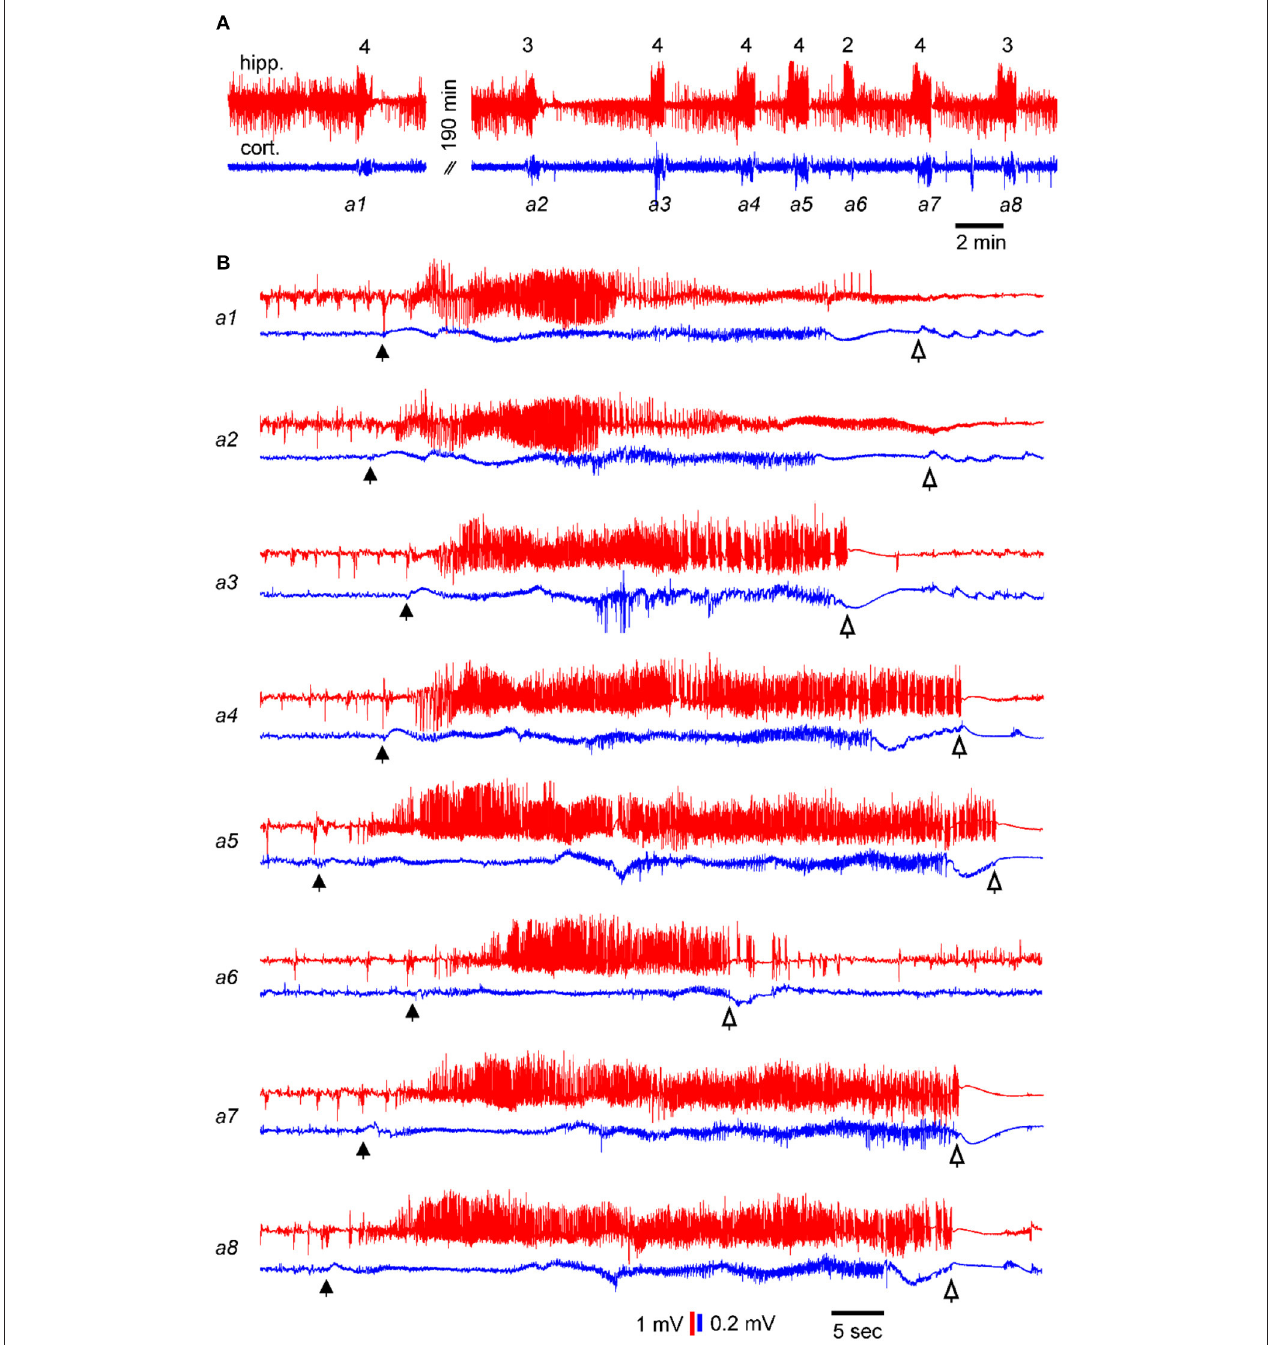
FIGURE 2 | Examples of consecutive SRS events. Data showing electroencephalogram (EEG) signals recorded simultaneously from the kindled hippocampus (red) and ipsilateral parietal cortex (blue) of a single mouse. EEG signals were collected in a wide-frequency band (0.1–1000Hz). (A) EEG traces showing 8 consecutive discharges. Corresponding motor seizure scores are indicated above the hippocampal discharges. (B) Sequential discharges were expanded. Filled and open arrows denote putative discharges onset and termination points, respectively. Note, in A, the first and second discharges were approximately 190min apart, whereas the inter-seizure intervals of subsequent seizures were